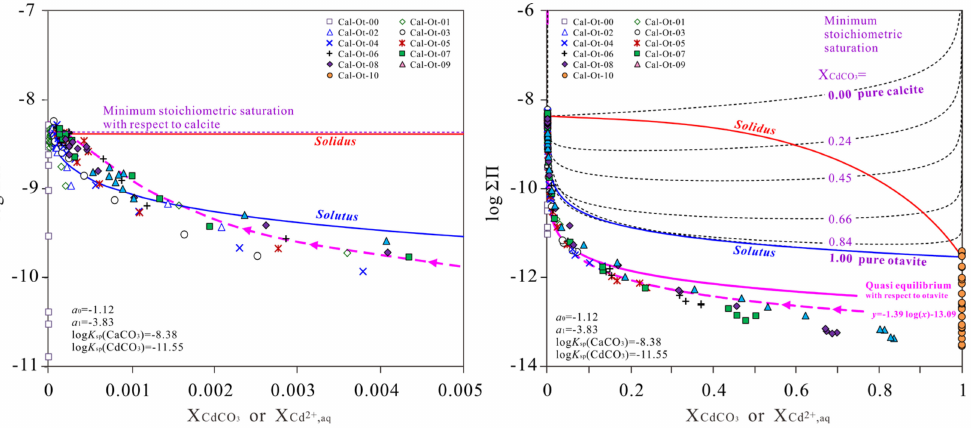
Figure 8. Lippmann diagram for the non-ideal (Ca 1 − x Cd x )CO 3 solid solutions together with the plot of some stoichiometric saturation curves and the experimental data for dissolution in the CO 2 - saturated water. The graph on the left is a zoom of the one on the